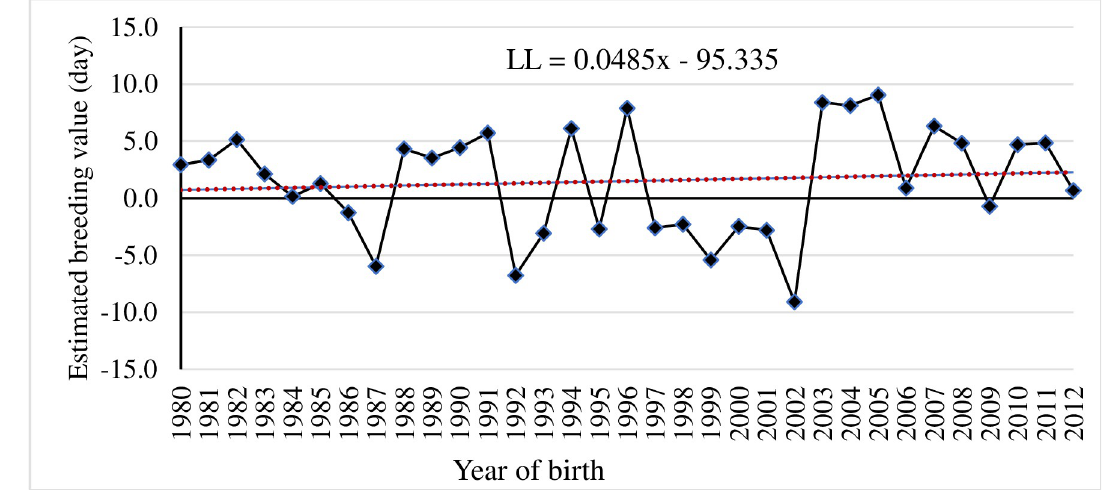
Fig 5. Genetic trend for lactation length (LL) by year of birth of Sahiwal cows.